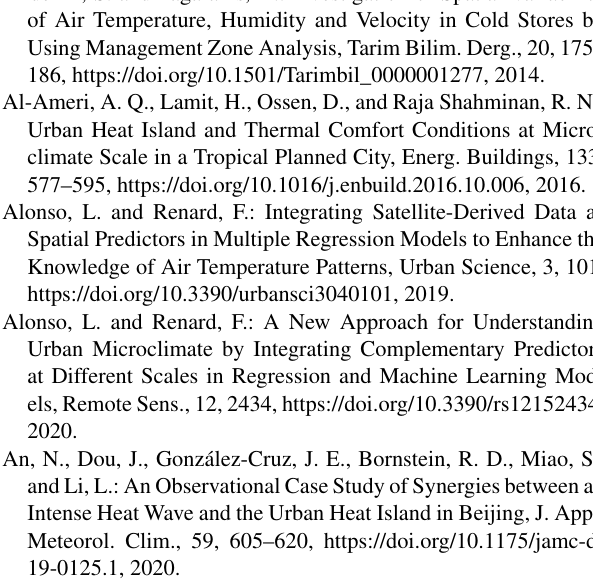
nations. Figure S2: the predicted error of the air temperature by ran- dom forest: (a) 11 August 2013; (b) 2 September 2015; (c) 21 July 2017. Figure S3: spatial distribution of air temperature and wind vector field in Nanjing and the reference rural area during